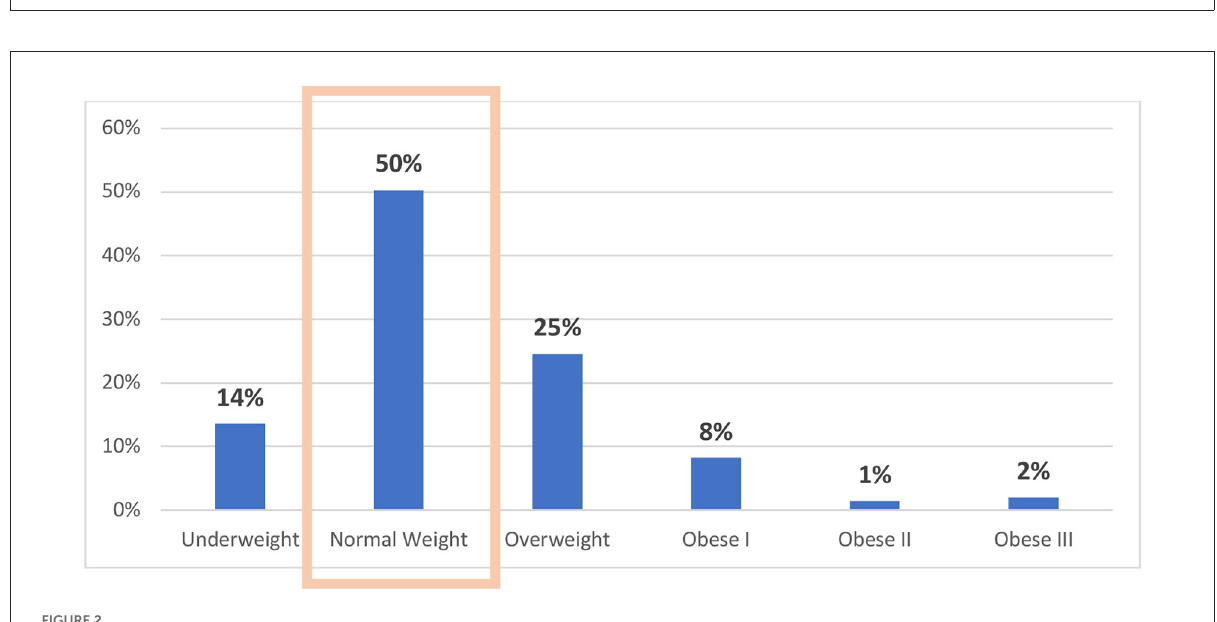
FIGURE2 Distribution of Body Mass Index